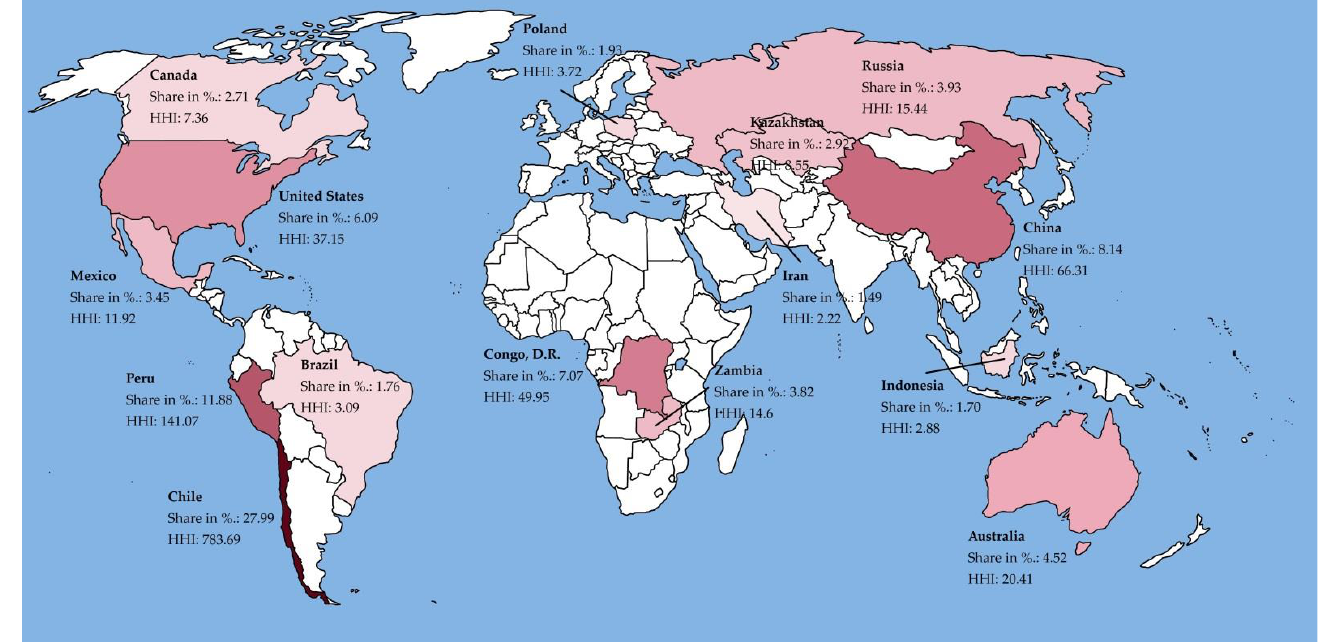
Figure 2. Herfindahl-Hirschman index (HHI) and copper production in 2020.